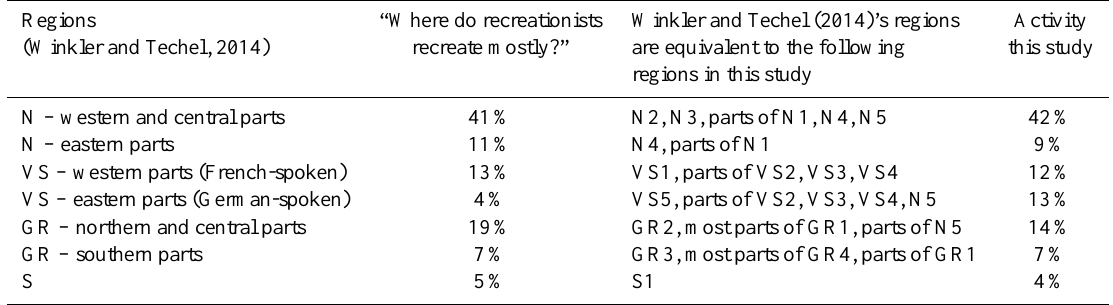
Table A1. Unpublished data (with permission from Kurt Winkler) from a survey concerning the avalanche bulletin (Winkler and Techel, 2014) and the corresponding values from this